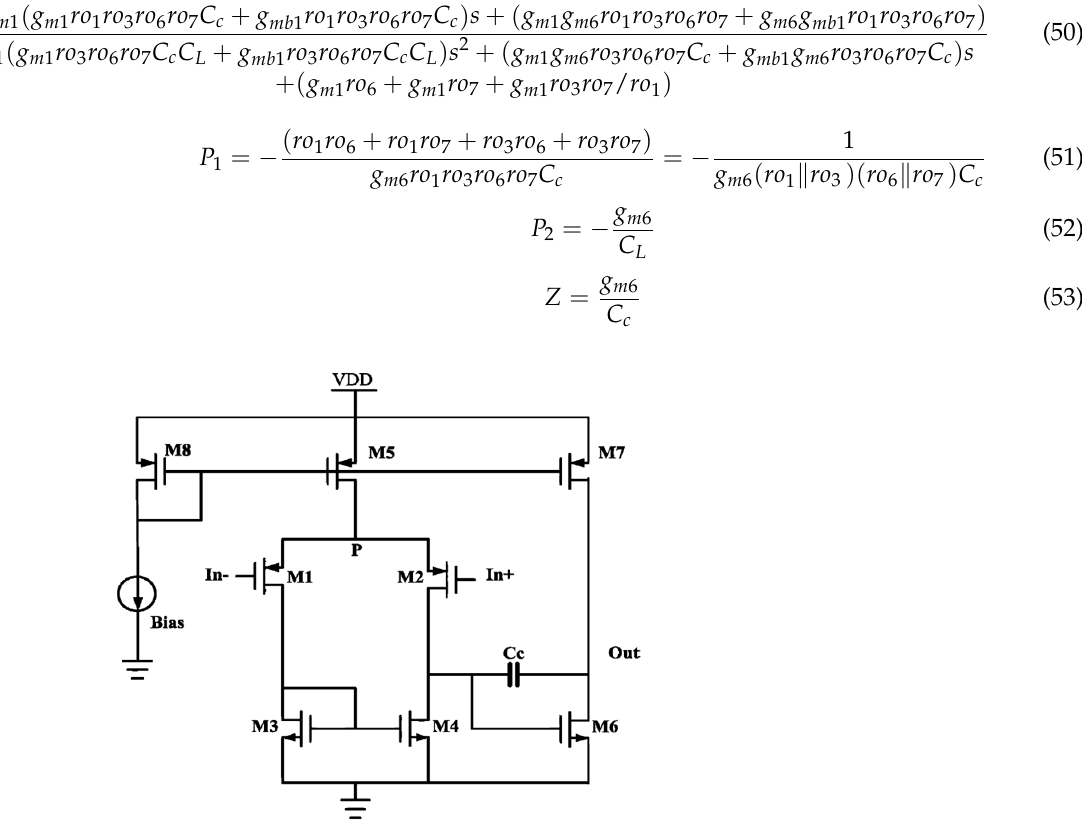
Figure 7. Two-stage compensation amplifier. Table 6. Number of terms within the simplified symbolic poles/zeroes in Circuit 2.